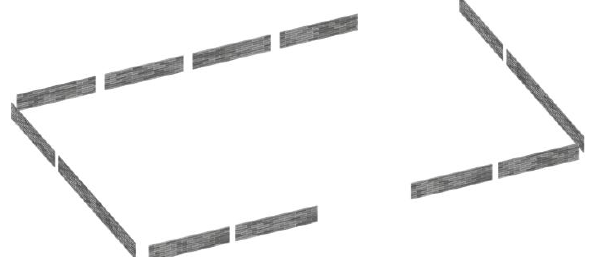
Figure 6. Rebuild of walls